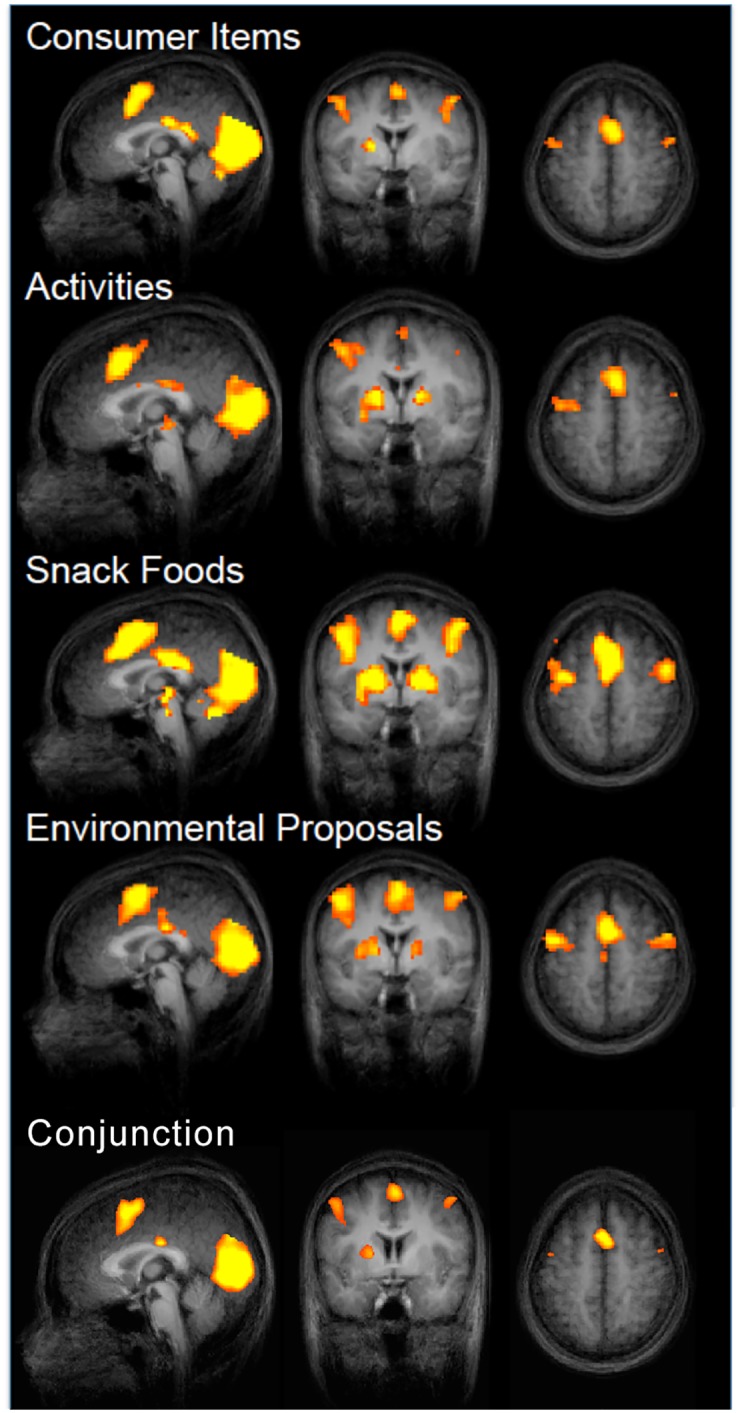
A nonparametric regression for each trial type in contrast to inter-trial intervals reveals identical activations (p < 0.001, FDR corrected) within dorsomedial prefrontal cortex (dmPFC), posterior cingulate cortex (PCC), ventral striatum, visual cortical areas, and superior frontal sulcus.